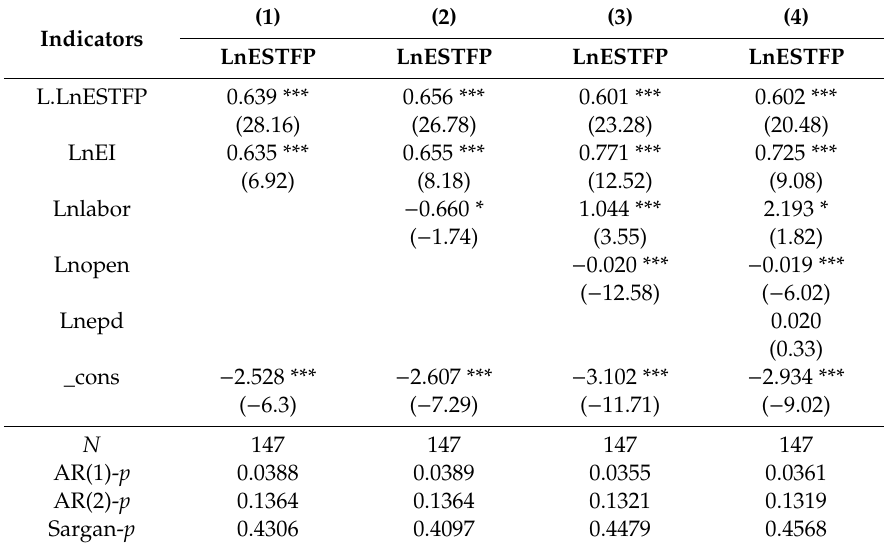
Table 6. Regression Results of the System GMM